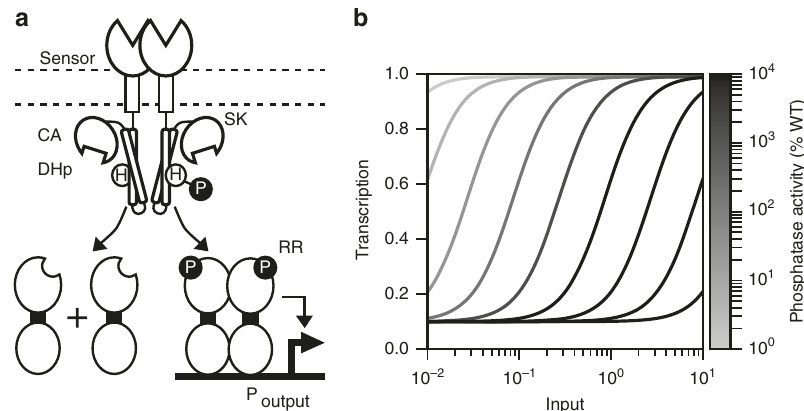
Fig. 1 Mathematical model reveals that SK phosphatase activity tunes TCS detection threshold. a Diagram of a canonical TCS. b Model simulations of the relationship between TCS input concentration and transcriptional output rate (i.e., transfer function) wherein SK phosphatase activity is varied between 1% and 10,000% of wild-type (Supplementary Note 1). Detection threshold ( K 1/2 ), or the input concentration where transcriptional output is half-maximal, increases with phosphatase activity. There is no trade-off between detection threshold and dynamic range for intermediate changes in phosphatase activity; however, a trade-off emerges for strong changes in phosphatase activity (Supplementary Fig.